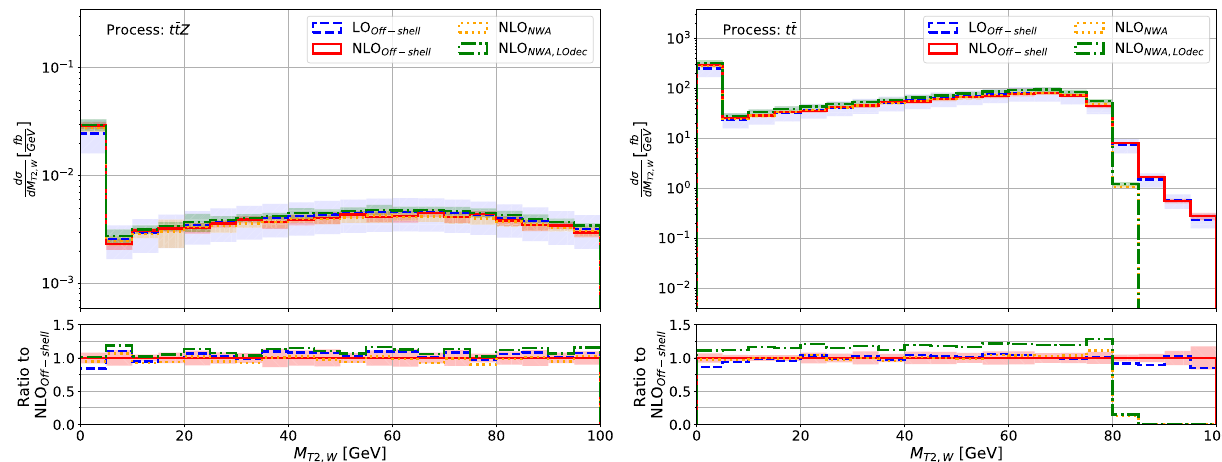
√ s = 13 TeV. The error